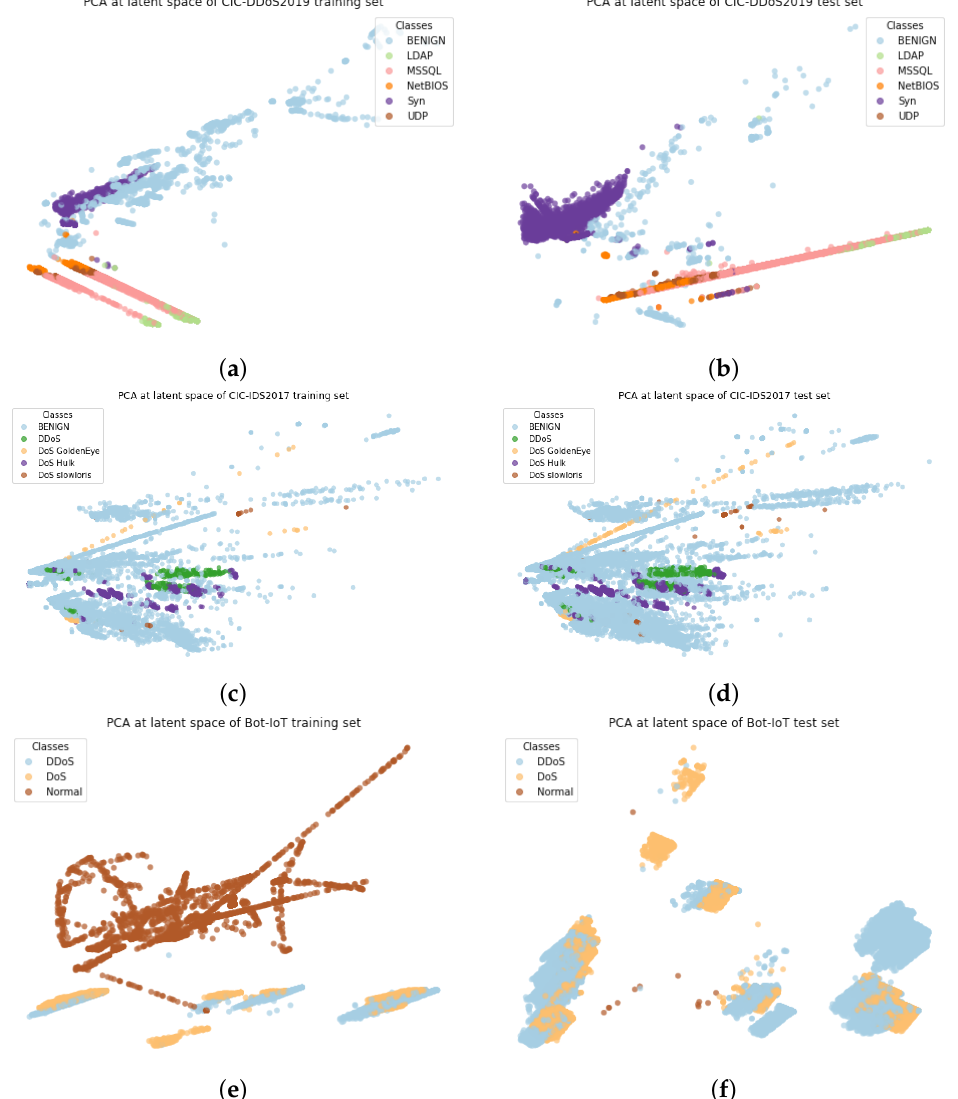
Figure 4. PCA visualization of data distribution of datasets. ( a ) CICDDoS2019 Training set; ( b ) CICDDoS2019 Test set; ( c ) CIC-IDS2017 Training set; ( d ) CIC-IDS2017 Test set; ( e ) Bot-IOT Training set; ( f ) Bot-IOT Test